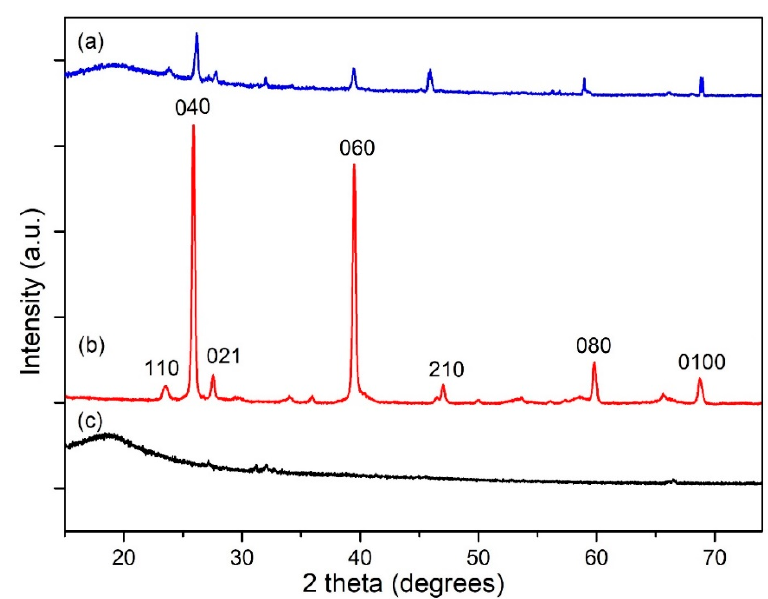
Figure 7. XRD patterns showing the incorporation of MoO 3 nanobelts in 15 w / w % PPy / SIS blend: ( a ) MoO 3 / PPy / SIS nanocomposite; ( b ) MoO 3 nanobelts; ( c ) PPy / SIS blend (15 w / w%).